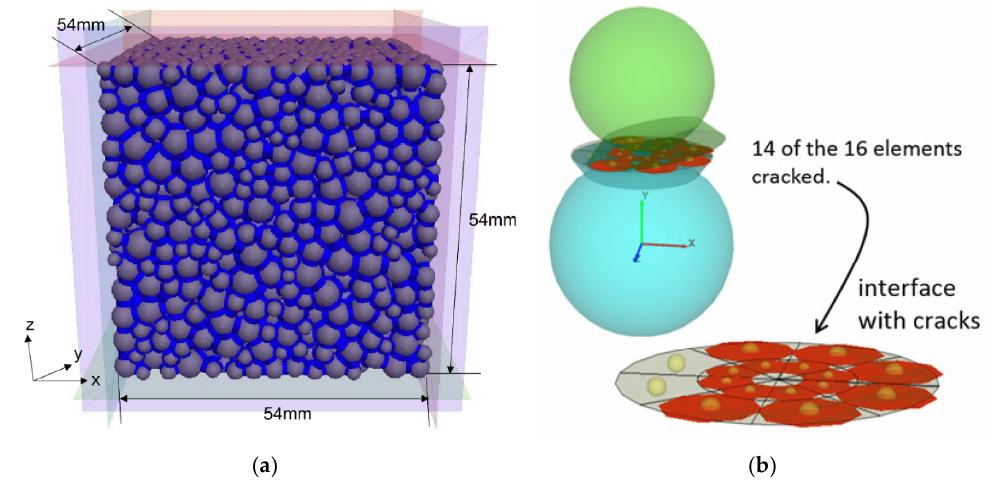
Figure 5. ( a ) The cubical FJ BPM made up of 3618 grains and 17,110 FJ contacts used in the